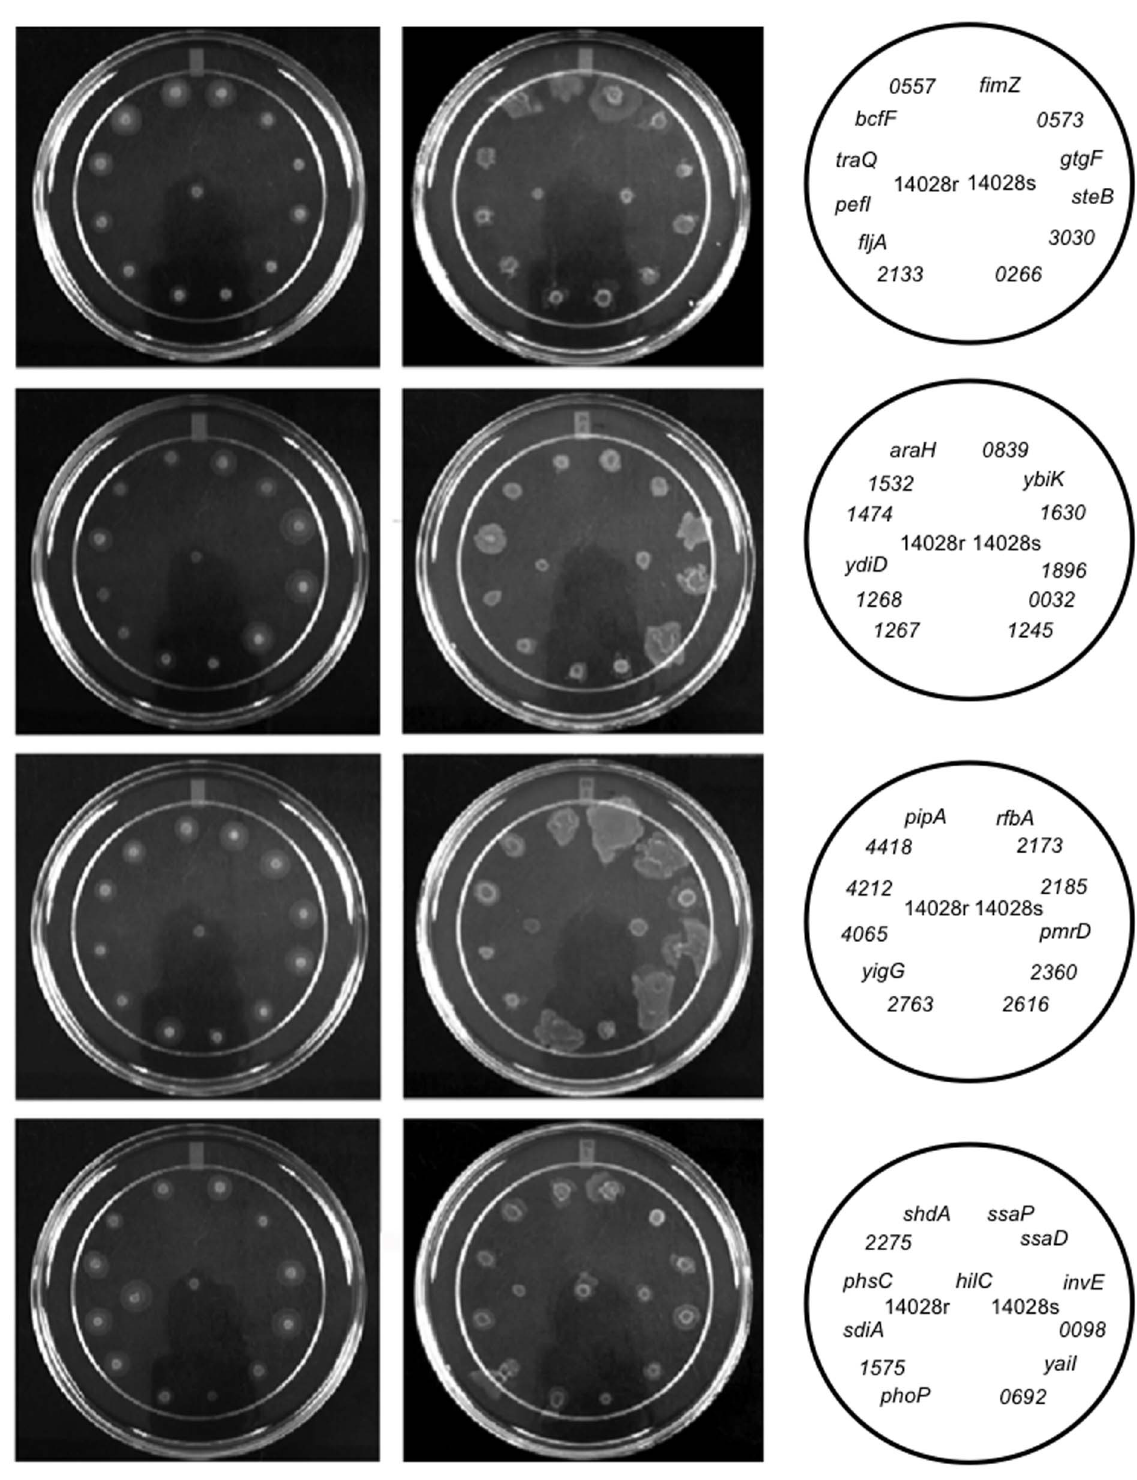
Figure 4. Confirmation of hypermotility phenotypes. Stationary cultures normalized by OD 600 were spotted on swimming or swarming agar along with wild type strain, ATCC14028s. Rough strain, ATCC 14028r, was used as a negative control on swarming agar. After 3.5 and 5 hours of incubation at 37 u C on swimming or swarming plates, respectively, the diameter of each bacterial growth area was measured in three independent experiments, with each experiment performed in triplicate.